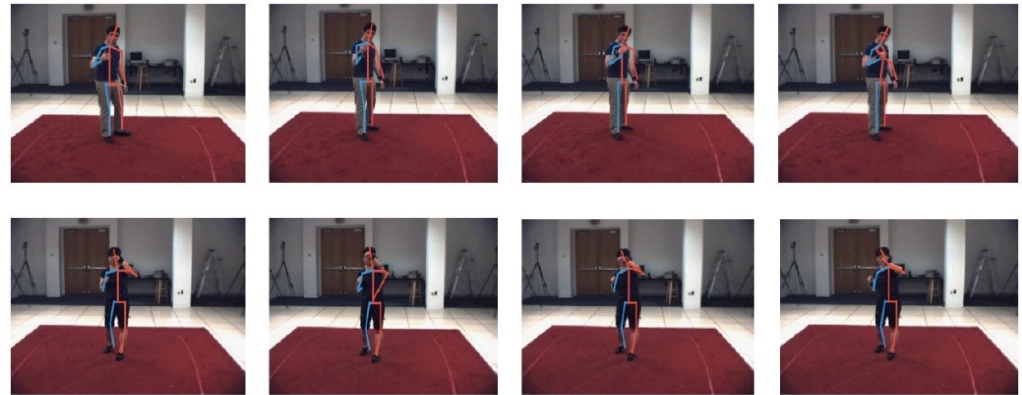
Figure 2. Illustration of skeleton joints of sequence sequential frames can be incoherent due to independent error in each frame.